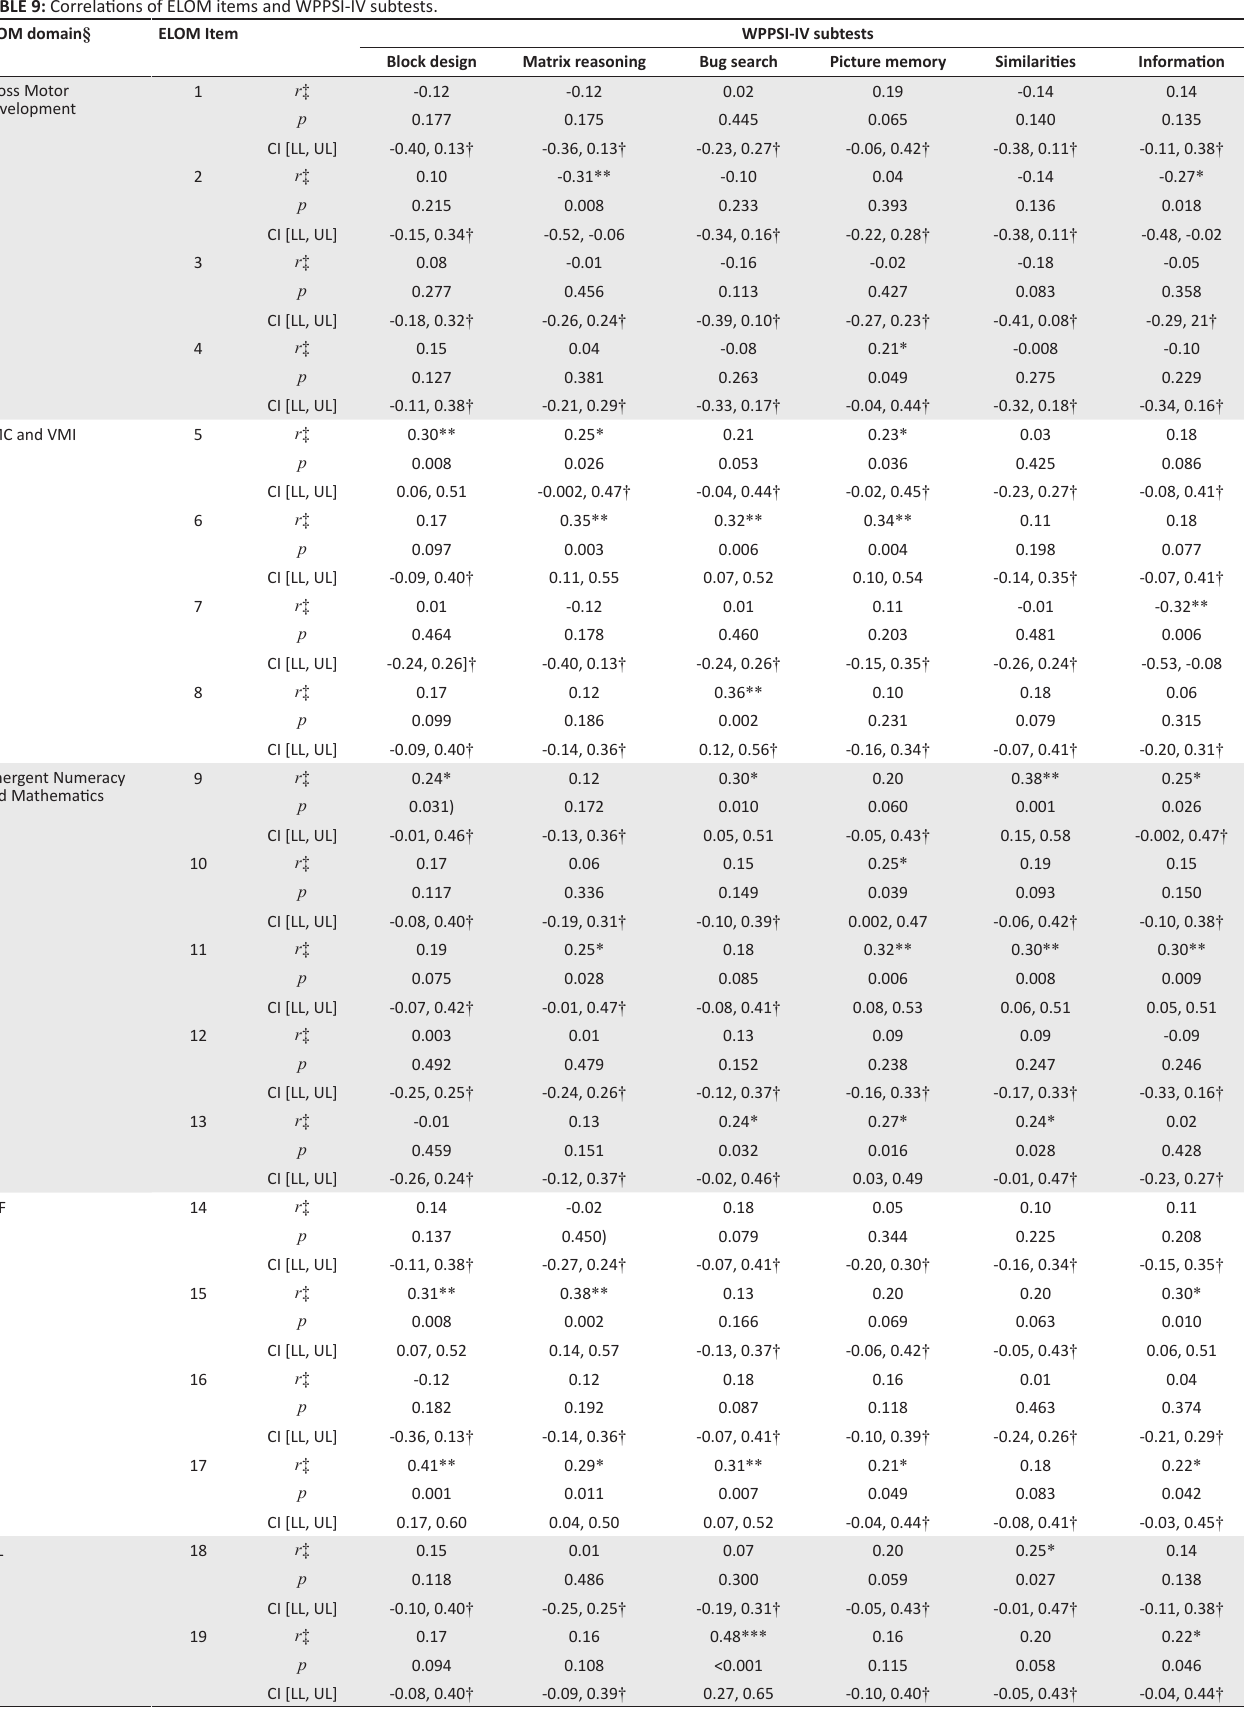
TABLE 9: Correlations of ELOM items and WPPSI-IV